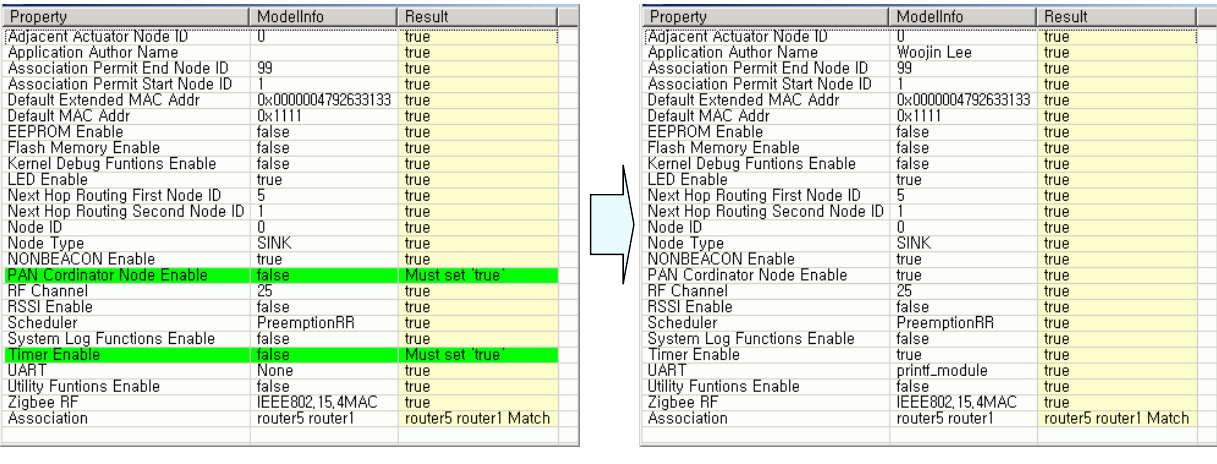
Figure 9. The result of node verification for